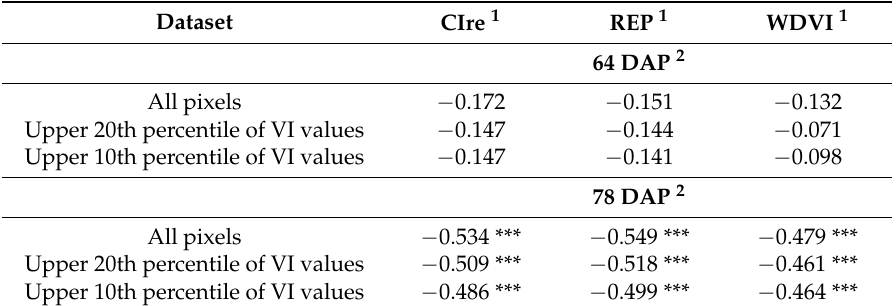
Table A7. Kendall-tau correlation coefficients between disease severity classes (as ordinal variable) and median of vegetation indices (VIs; as continuous variable) for UAV data at sampling unit level for assessment made 64 and 78